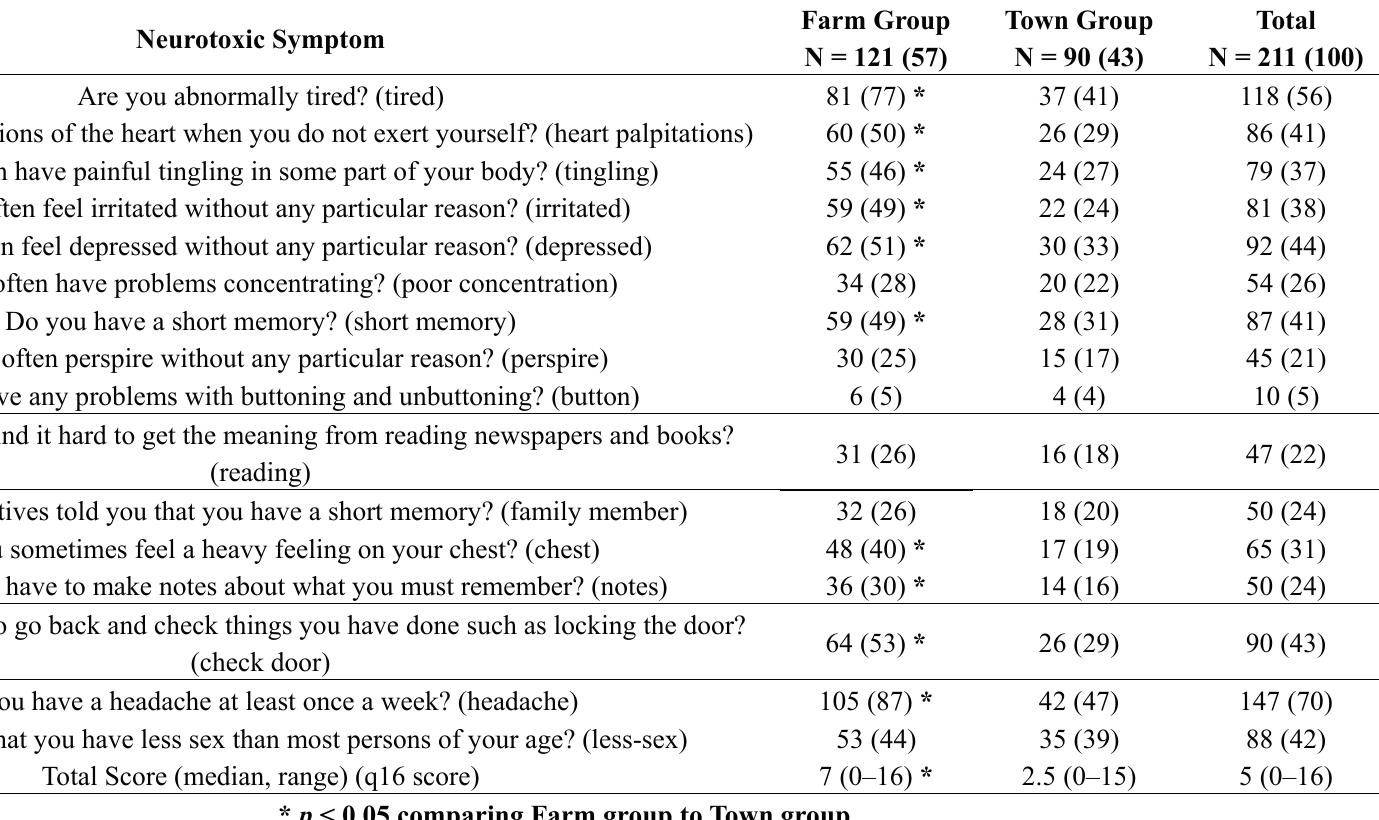
Table 4. Responses to